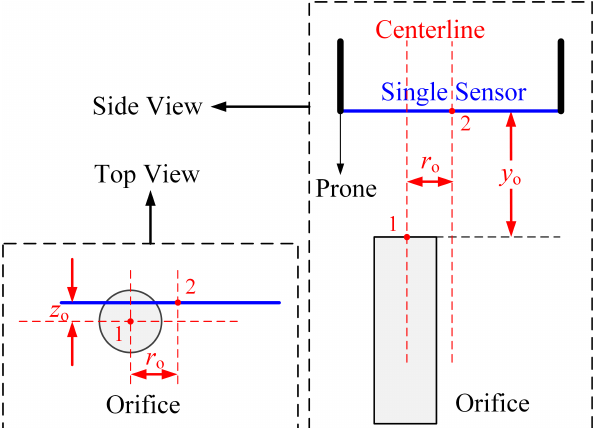
Figure 8. Definition of hot-wire probe position in the measurements of synthetic jet velocity charac- teristics. Point 1 refers to the center of the orifice, and point 2 refers to the midpoint of the hot-wire.